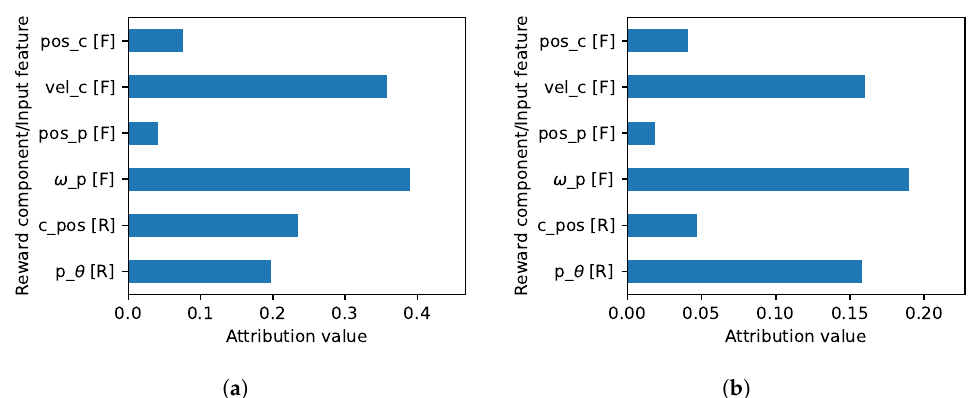
Figure A3. The normalized explanations of the cartpole agent where the importance of the input features and the reward components are compared in the same plot. ( a ) Normalized explanation at the Q-function level. ( b ) Normalized explanation when the reward weight is applied (at